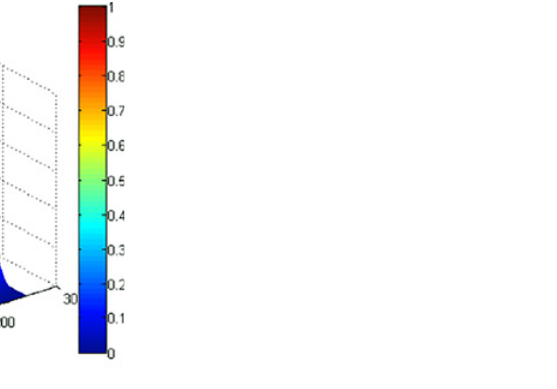
Fig 8. Modified 2-D Hanning window.